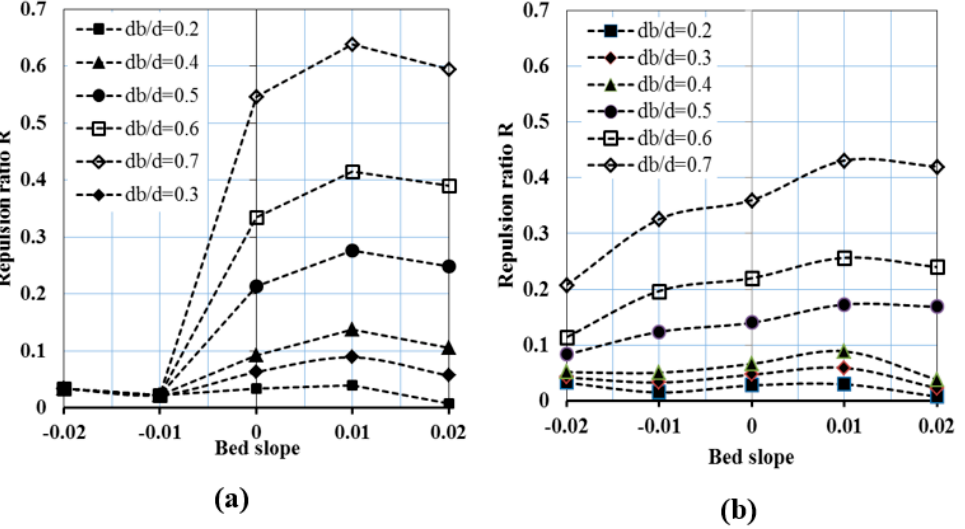
Figure 11. Relationship between the bed slope and R for barrier wall distance: ( a ) 0.20 and ( b ) 0.40.